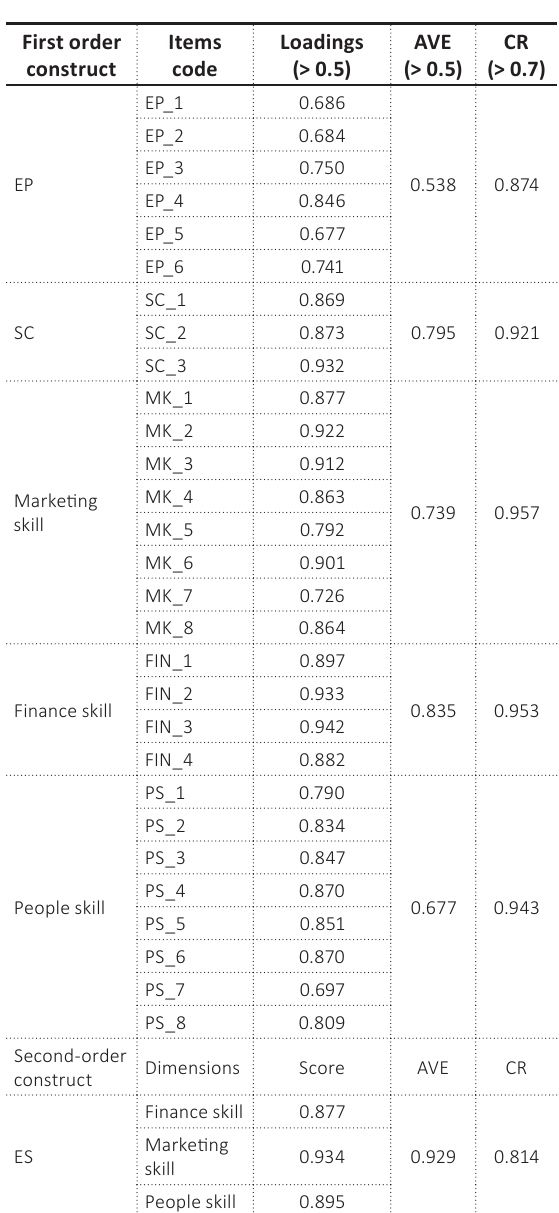
Table 2. Mardia’s multivariate skewness